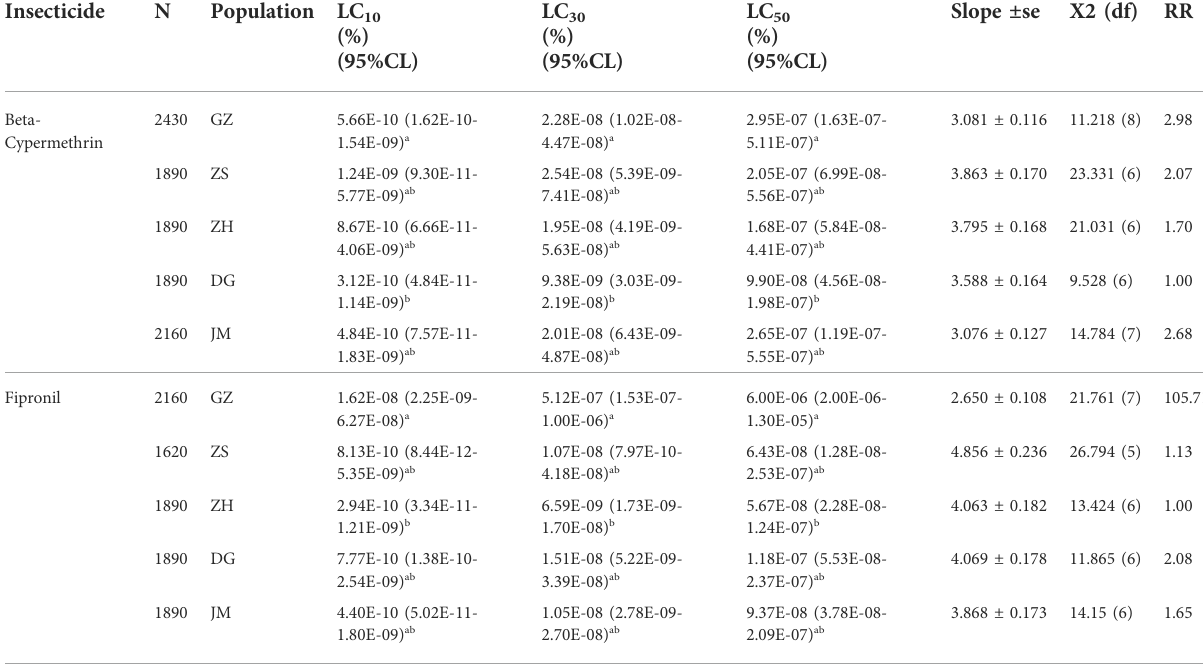
TABLE 1 LC 10 , LC 30 and LC 50 values of Solenopsis invicta obtained under insecticide exposure.